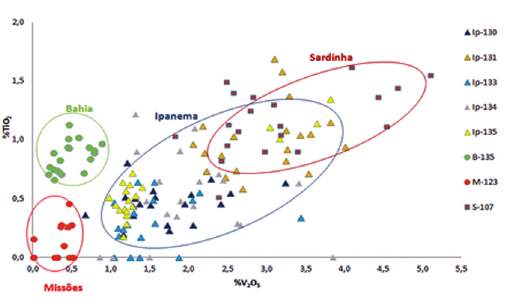
Figure 3: Bivariate graph showing the amount of oxides (%TiO O ) in the wüstite phase of the slag inclusions. versus %V 2 5